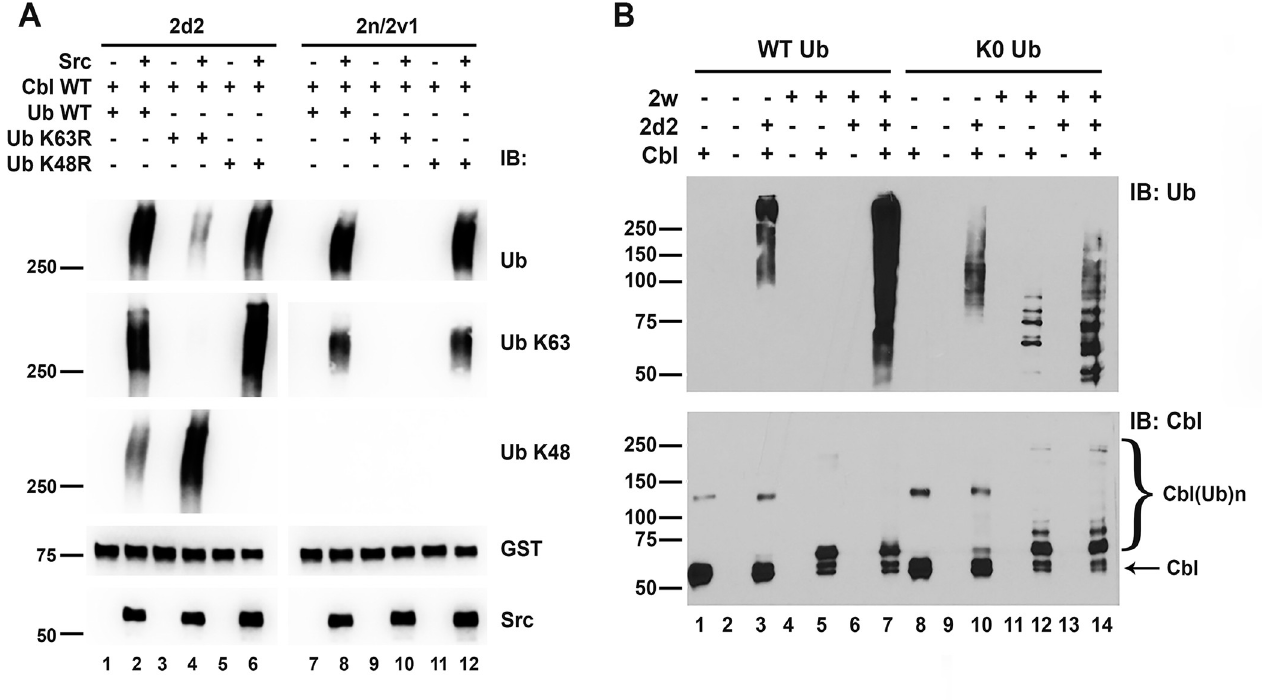
Fig 5. E2 determines the type of ubiquitin links formed by Cbl. ( A) Ube2d2 or Ube2n/2v1 were incubated with WT GST-Cbl with either WT ubiquitin (Ub), K63R or K48R mutant Ub with or without Src as indicated. Reactions were immunoblotted and probed with anti-Ub, Ub K63-specific, Ub K48-specific, anti- GST and anti-Src antibodies. MW in kDa is shown to the left of the panels. (B) Cbl, cleaved from the GST protein, and Ube2w were incubated for 20 minutes with wild-type ubiquitin (WT Ub) or ubiquitin mutant (K0 Ub) and then Ube2d2 was added to the reaction as indicated. Assays were performed for 40 minutes in total and immunoblotted (IB) for ubiquitin (Ub) and